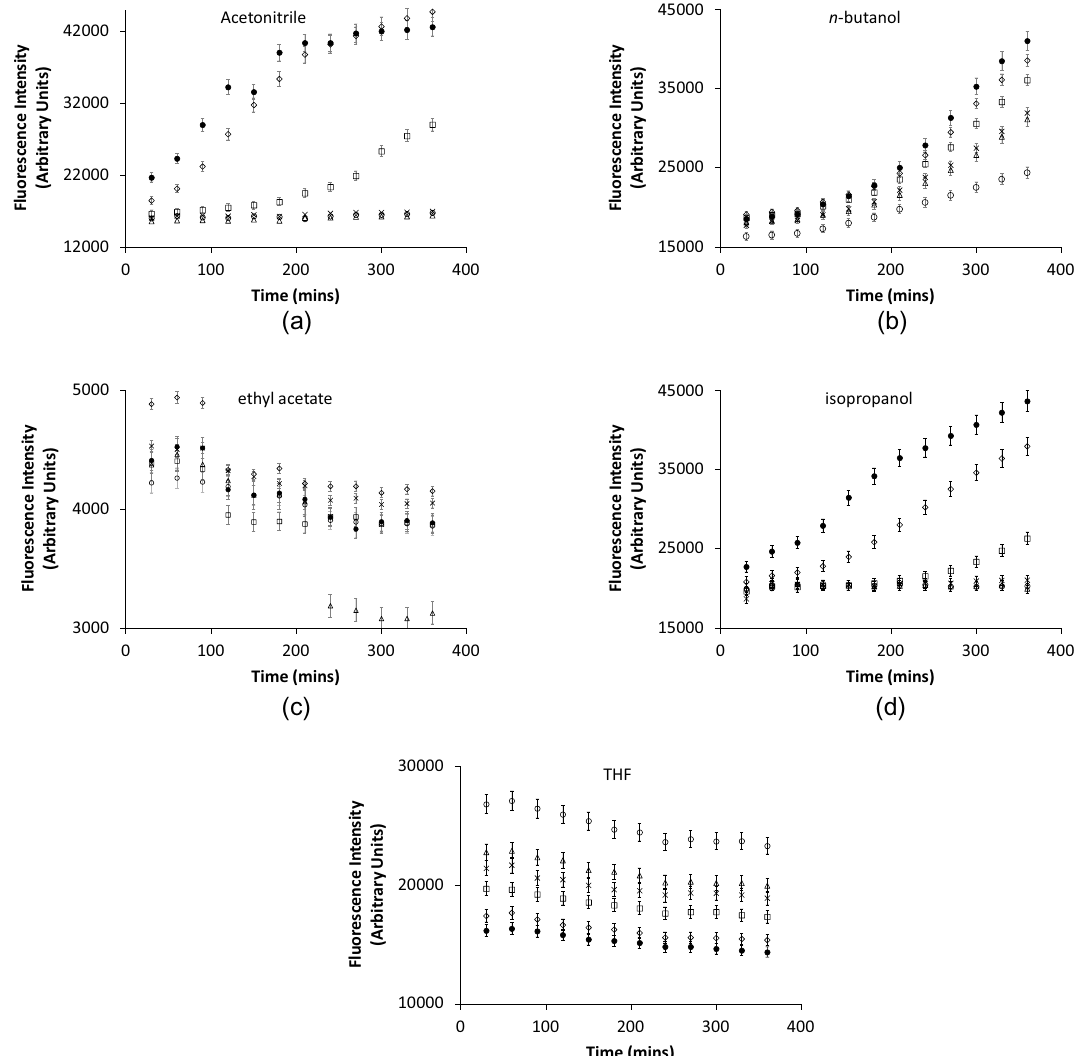
Figure 7. Time dependence of fluorescence intensity at various organic solvent concentrations for holo-TK. Fluorescence intensity was measured at 340 nm with excitation at 280 nm. Holo-TK at 0.1 mg mL −1 , in 5 mM MgCl 2 , 0.5 mM TPP, 25 mM Tris–HCl, pH 7.0, was measured every 30 min for 6 h at 25 °C in (open circle) 5%, (open triangle) 10%, (x)15%, (open square) 20%, (open rhombus) 25% and (filled circle) 30% ( a ) acetonitrile ( b ) n-butanol ( c ) ethyl acetate ( d ) isopropanol ( e ) THF. Error bars represent one standard deviation about the mean (n =